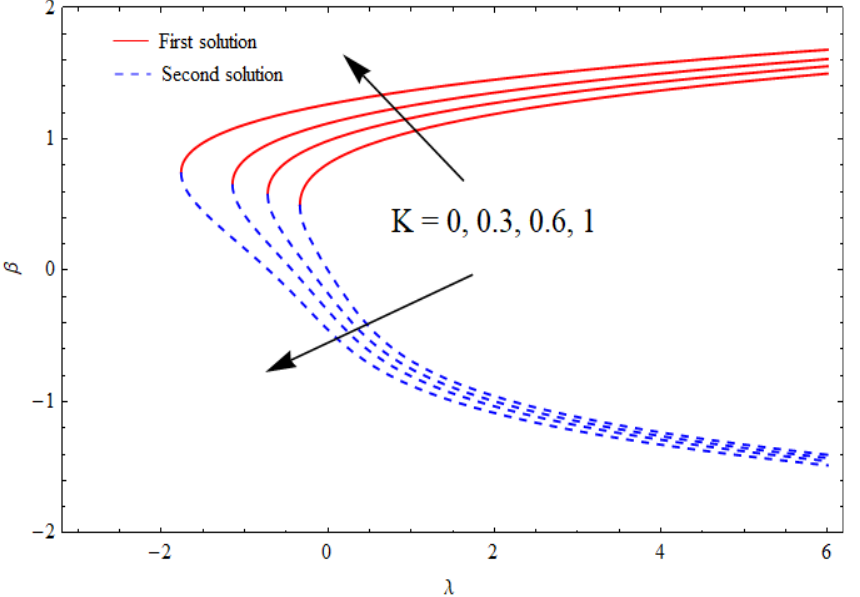
against stretching/shrinking parameter